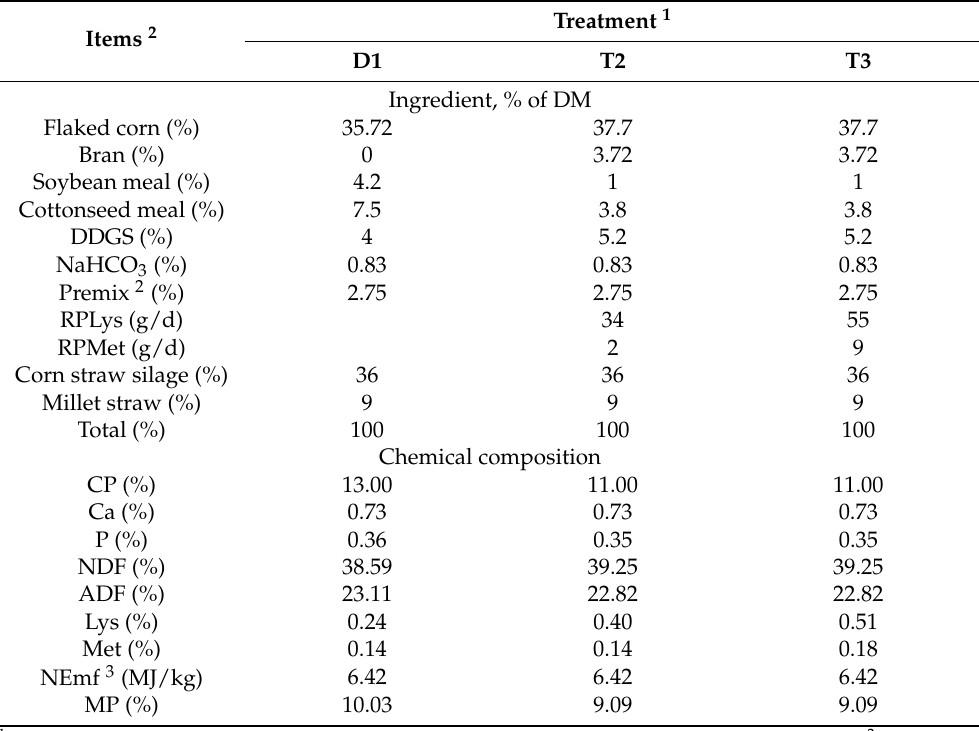
Table 1. Ingredients and chemical compositions of experimental